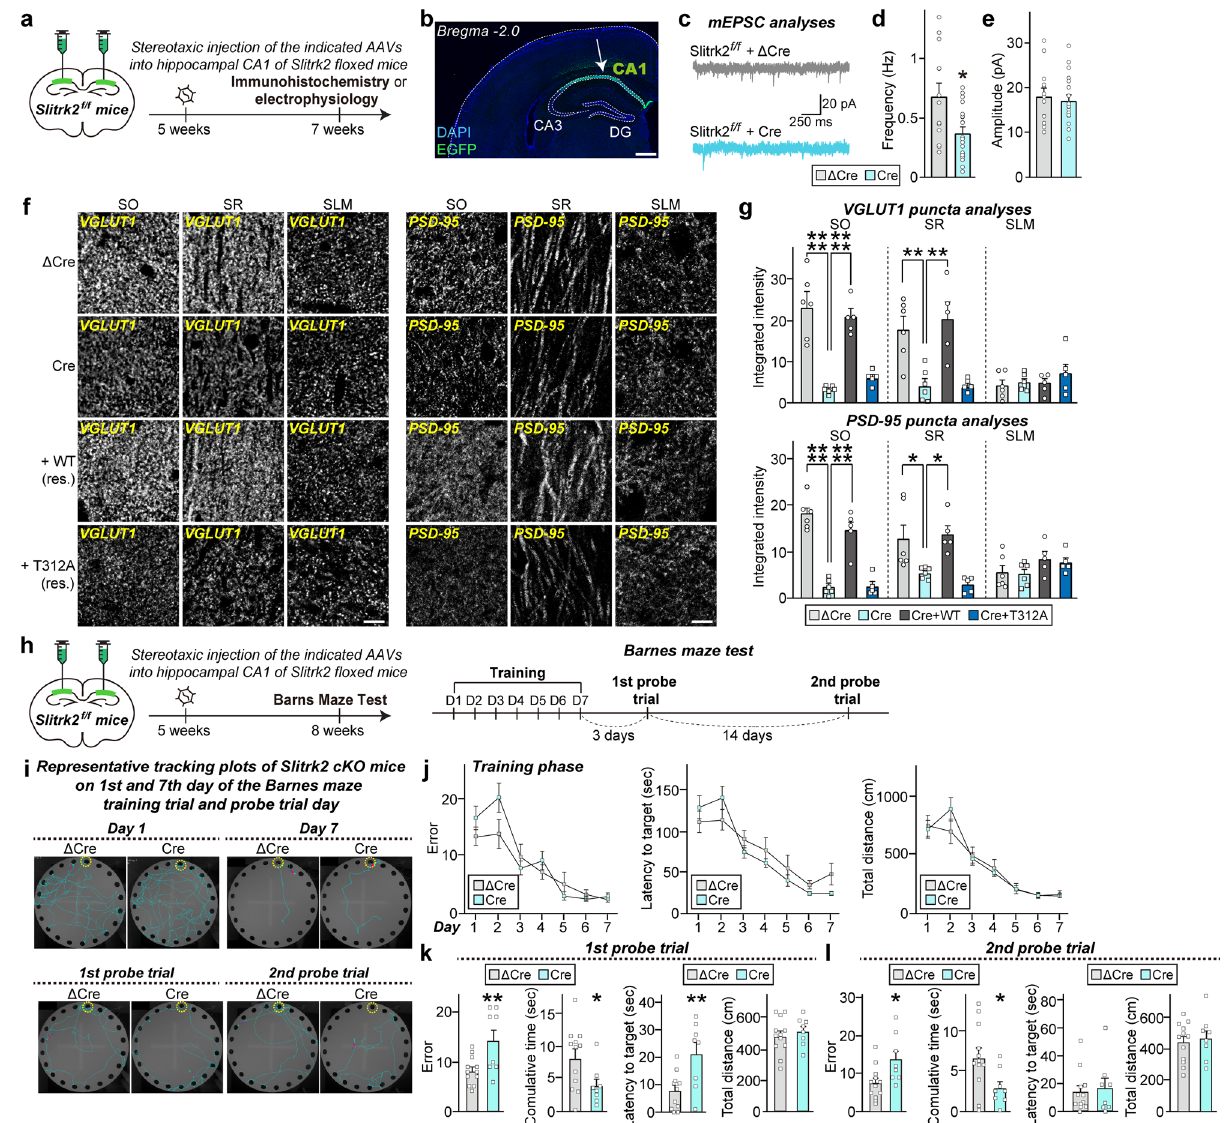
Fig. 9 Proper Slitrk2 function in the hippocampal CA1 is required for mediating spatial reference memory in mice. a Experimental con fi guration for electrophysiology and immunohistochemistry experiments ( c – g ). b Representative brain sections illustrating the precise targeting of AAVs for expression of Cre recombinase in the hippocampal CA1. Scale bar: 500 µ m. c – e Representative traces ( c ) and summary graphs showing the frequency ( d ) and amplitude ( e ) of mEPSCs recorded from Slitrk2- fl oxed mice injected with AAVs expressing Δ Cre or Cre. Data are shown as means ± SEMs ( Δ Cre, n = 13; Cre, n = 20; * p < 0.05; two-tailed Mann – Whitney U test). f , g Representative images ( f ) and summary graphs quantifying the integrated intensity ( g ) of VGLUT1 and PSD-95 puncta. Data are shown as means± SEMs ( Δ Cre, n = 6; Cre, n = 6; Cre + WT, n = 5; and Cre + T312A, n = 5 mice; * p < 0.05, ** p < 0.01, **** p < 0.0001; ANOVA with Tukey ’ s test). Scale bar, 10 µ m (applies to all images). h Experimental con fi guration for Barnes Maze tests ( i – l ). i Representative traces of locomotive behavior for Barnes Maze tests. Target box is indicated with a yellow circle. j Number of errors before fi rst encountering the escape hole, escape latency, and total distance for Slitrk2- fl oxed mice injected with Δ Cre (Control) or Cre during the training session. Data are presented as means ± SEMs ( Δ Cre, n = 12; Cre, n = 8; two-way ANOVA with Sidak ’ s multiple comparisons test). k , l Number of errors before fi rst encountering the escape hole for Slitrk2- fl oxed mice injected with Δ Cre (Control) or Cre during 1st ( k ) and 2nd ( l ) probe trials. Data are presented as means ± SEMs ( Δ Cre, n = 12; Cre, n = 8; * p < 0.05, ** p < 0.01; two-tailed unpaired t -test). See Source data for raw data values and Supplementary Table 4 for statistical represent loss-of-function mutations. One variant (E461 * ) in SLITRK2 WT to negatively regulate TrkB-FL levels in neurons, SLITRK2 was a nonsense variant, and resulted therefore in a revealing the signi fi cance of interactions between SLITRK2 and truncated SLITRK2 protein. The fi fth variant, T312A, induced TrkB in terms of preventing SLITRK2 dysfunction-induced normal surface expression, and normal extracellular ligand- pathogenic effects. Given the well-established centrality of TrkB- binding and synaptogenic activity, albeit with markedly reduced mediated signaling in excitatory synapse development 39 , it is plausible that selection of speci fi c binding partners (i.e., LAR- excitatory synapse number and excitatory synaptic transmission. RPTPs vs. TrkB) through fi ne regulation of SLITRK2-mediated Remarkably, these fi ve SLITRK2 variants abrogated the ability of